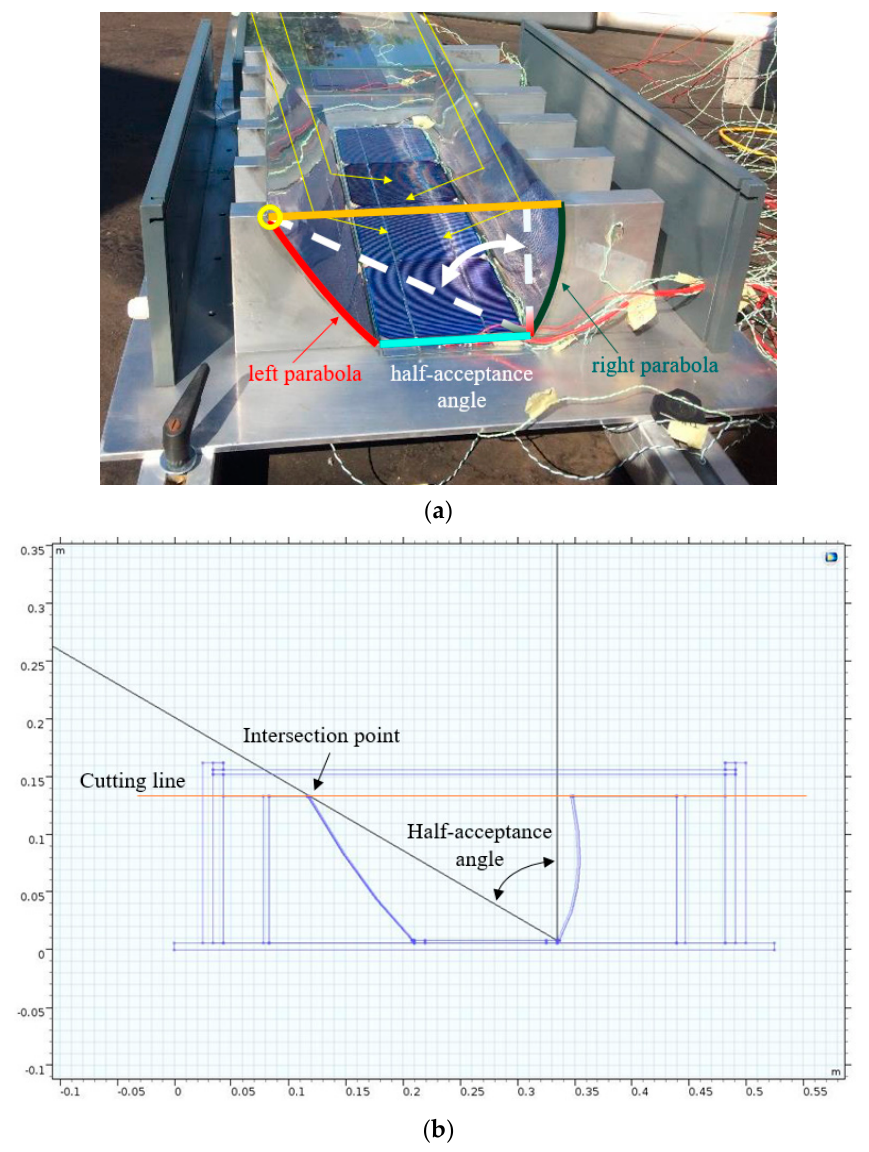
Figure 10. Realisation of reflectors geometry: ( a ) main parts of reflectors construction, ( b ) 2D scheme of the CPC system.